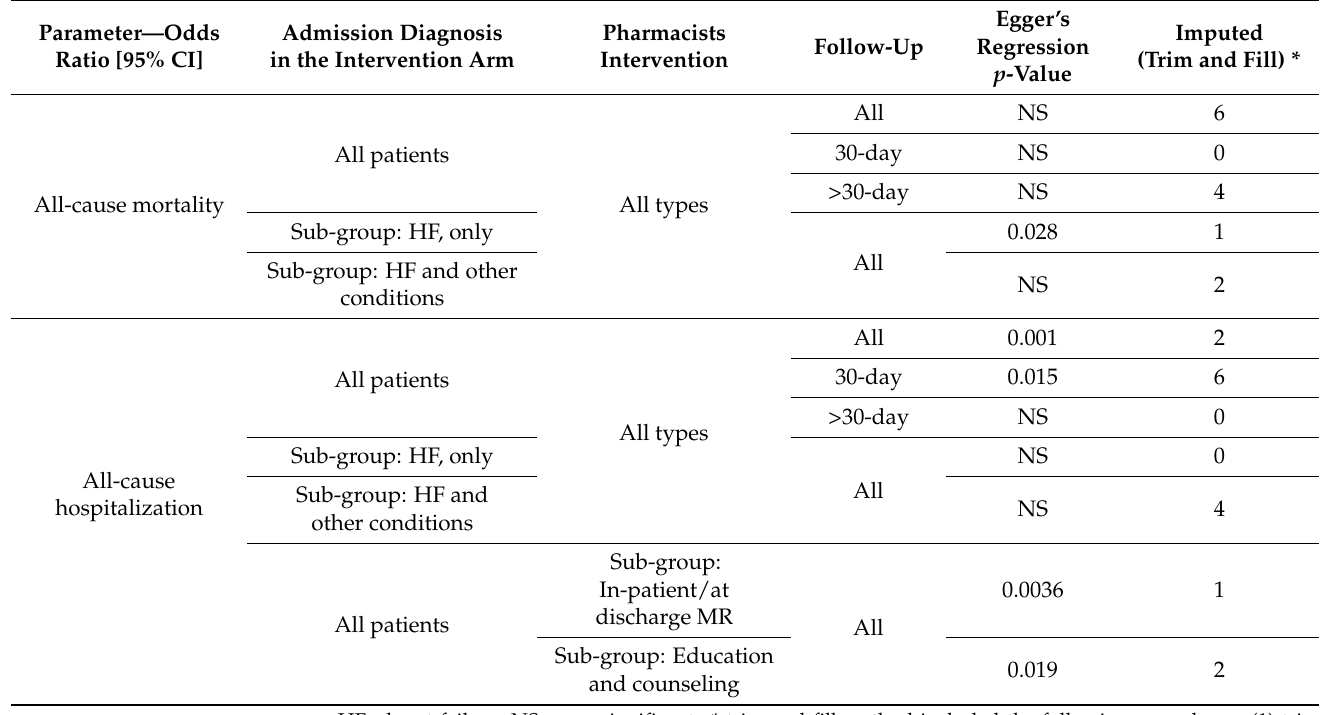
Table 1. Results from publication bias funnel plot and trim and fill